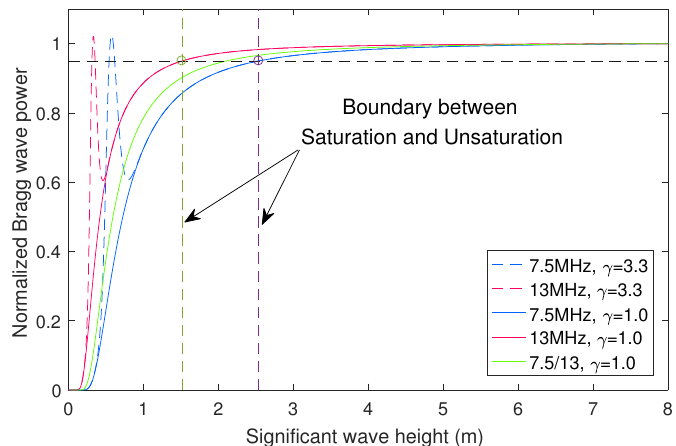
Figure 2. Normalized Bragg wave power at different wave height. The horizontal dashed line represents the threshold value of 95% of maxima. The corresponding wave height boundaries are drawn by the vertical dashed